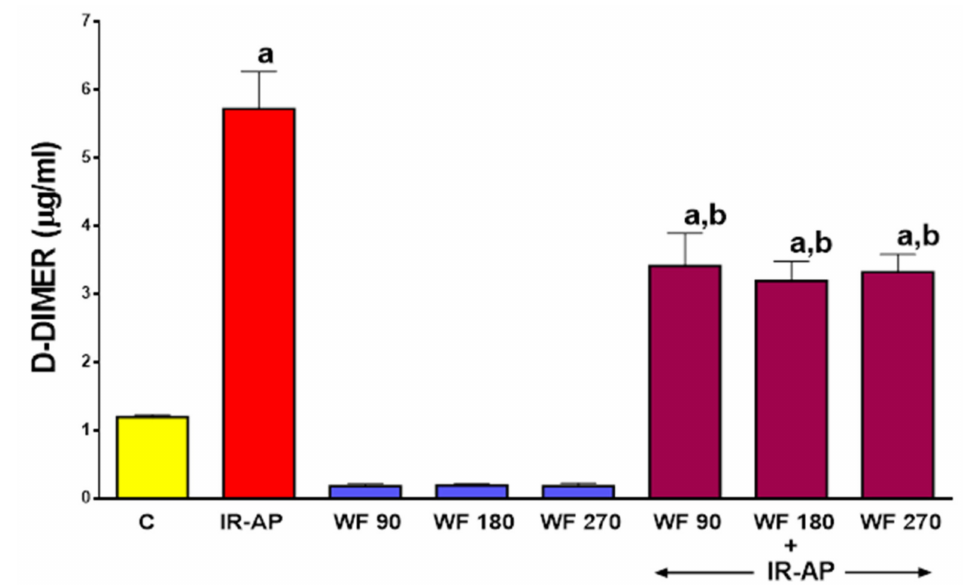
Figure 7. Impact of ischemia / reperfusion-induced acute pancreatitis (IR-AP) or / and pretreatment with warfarin given at a dose of 90, 180 or 270 µ g / kg / dose (WF 90, WF 180 or WF 270) on plasma D-Dimer concentration. Mean ± SEM. n = 10 animals in each experimental group. a p < 0.05 compared to control (C), b p < 0.05 compared to